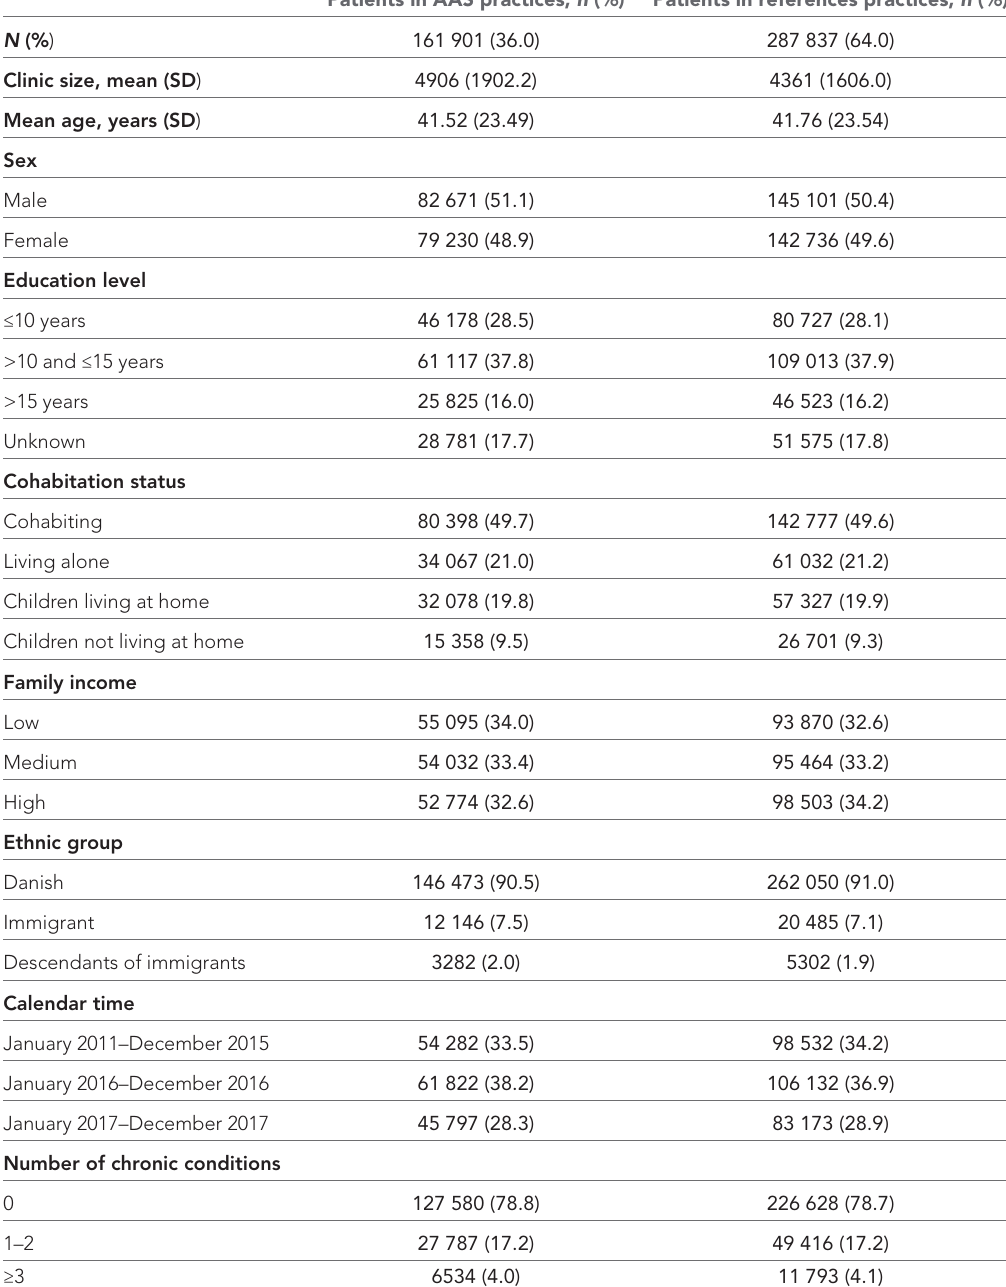
Table 1 Characteristics of study population at index date Patients in AAS practices, n (%) Patients in references practices, n